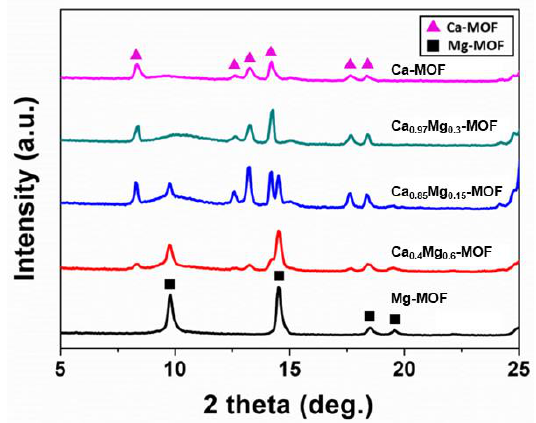
Materials 2020 , 13 , x FOR PEER REVIEW Figure 1. Powder X-ray diffraction showing the characteristic diffraction peaks of CaMg-MOFs. Figure 1. Powder X-ray di ff raction showing the characteristic di ff raction peaks of CaMg-MOFs.